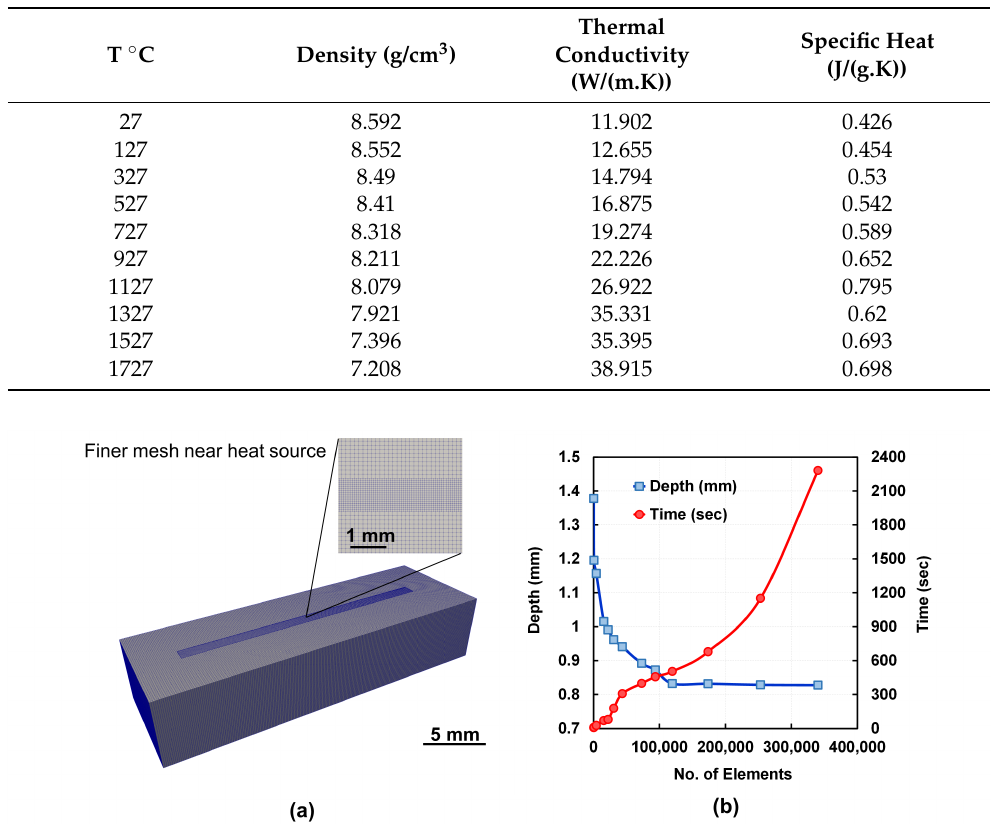
Figure 6. ( a ) Adaptive meshing applied to the simulation domain. ( b ) The variation of the melt pool depth and the simulation time with the number of mesh